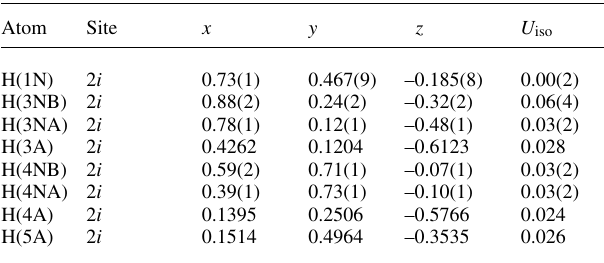
Table 2. Atomic coordinates and displacement parameters (in Å 2 )